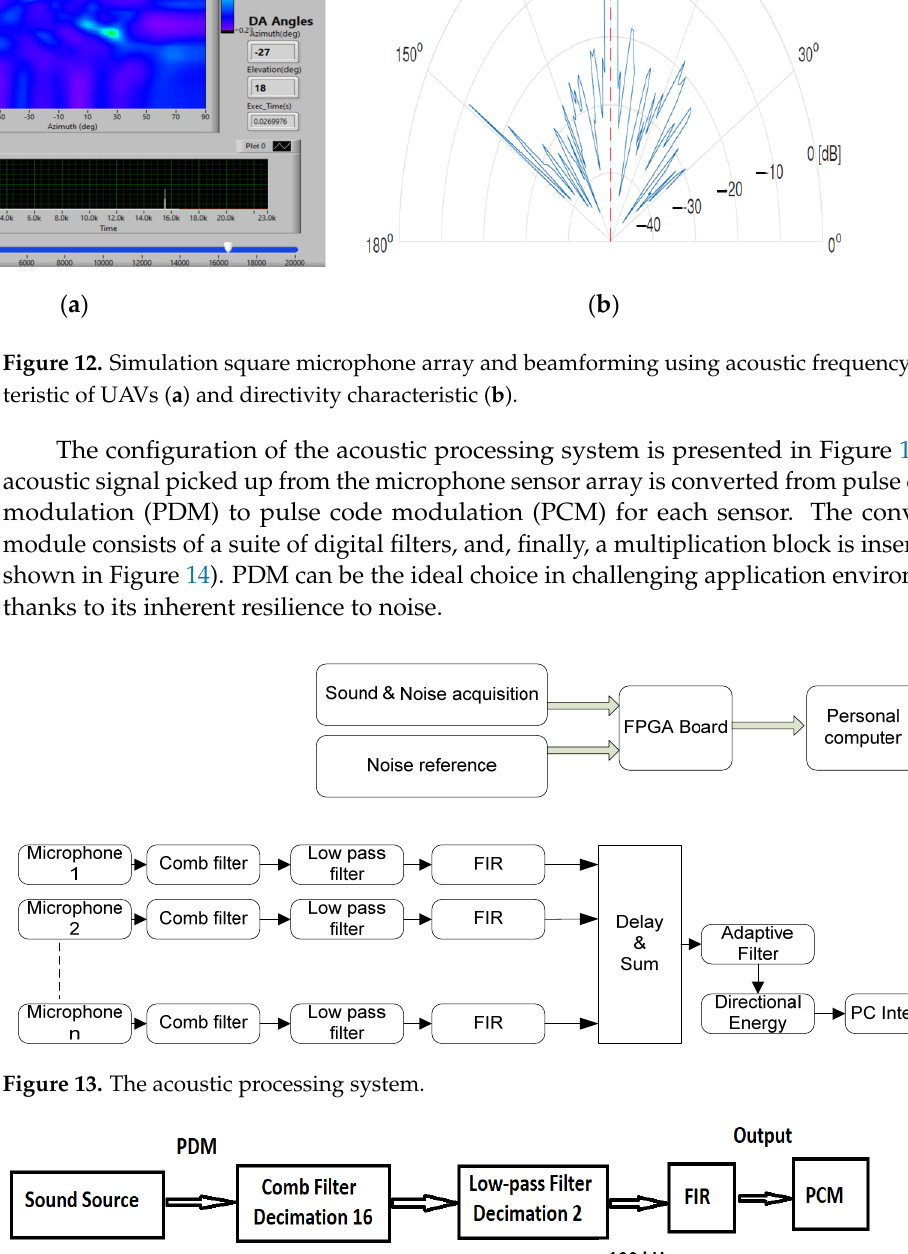
Figure 12. Simulation square microphone array and beamforming using acoustic frequency charac- teristic of UAVs ( a ) and directivity characteristic ( b ).